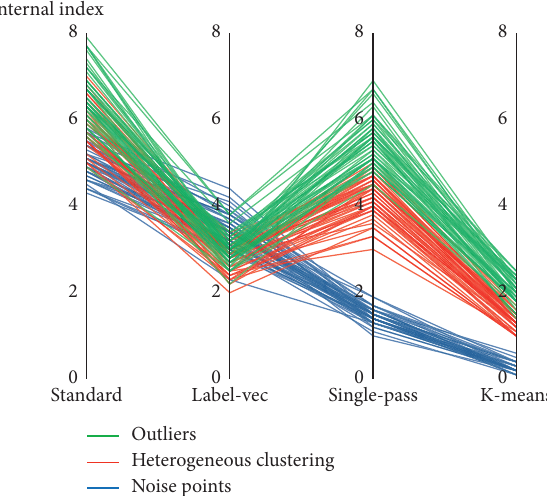
Figure 7: Comparison of internal index metrics of different